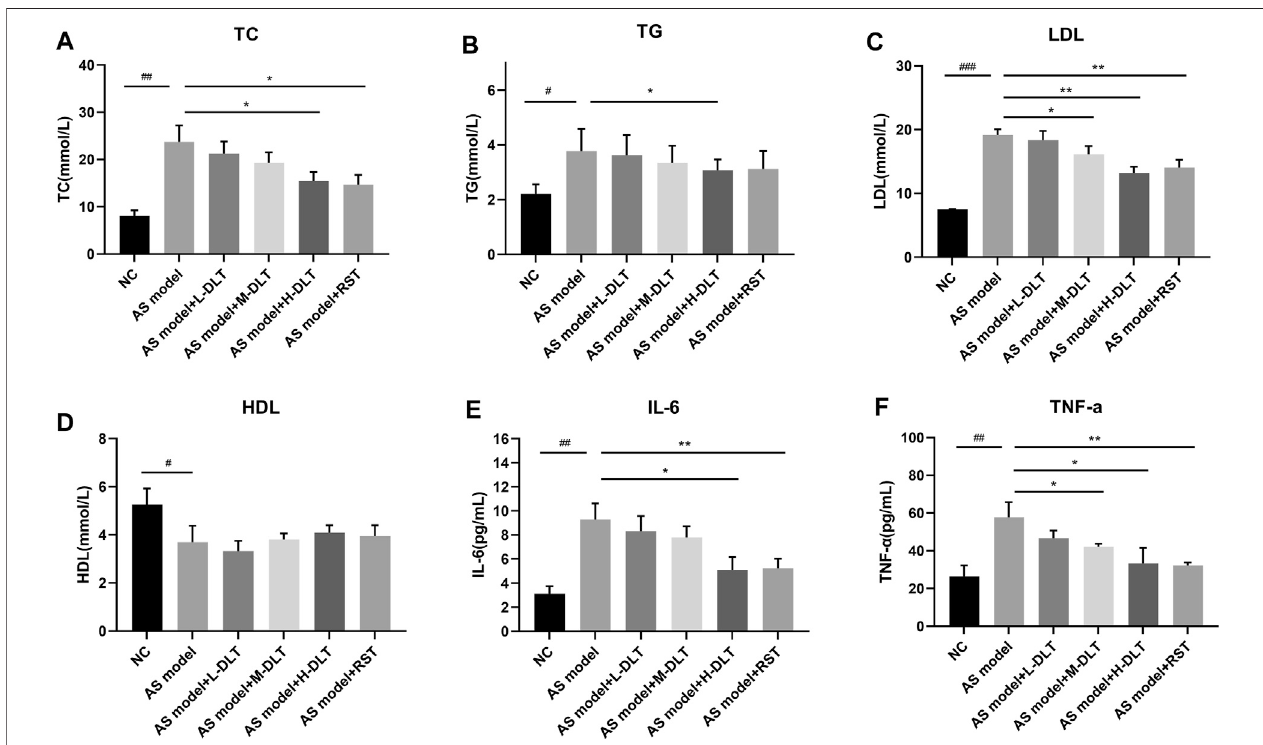
FIGURE 2 | The AS-related cytokines detection in a Danlou tablet-treated ApoE − / − mice model. (A – D) Lipid levels were detected by ELISA and biochemical test, includingLDL,HDL,TC,TG. (E,F) ELISAkitswereusedtochecktheimmunefactors(IL-6andTNF- α )indifferentgroups(# p < 0.05,## p < 0.01,### p < 0.001ASmodel group vs. normal control group; * p < 0.05, ** p < 0.01, *** p < 0.001 drug treatment group vs. AS model group, n (cid:1) 8, tested by one-way